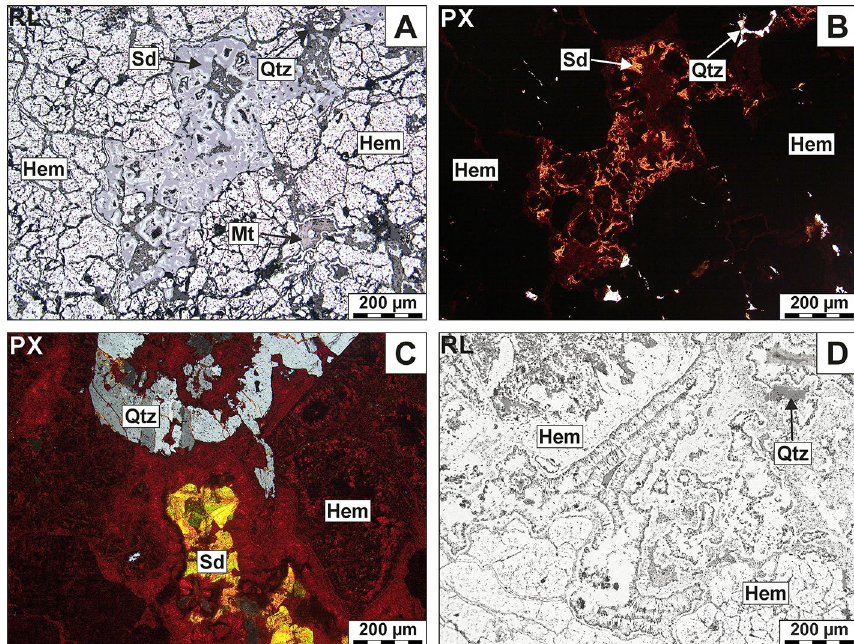
Figure 3. ( A , B ) Intergrowths made of siderite (Sd) and hematite (Hem) (central part of the image), surrounded by replacive isometric crystals of hematite (martite) formed after magnetite (Mt); ( C , D ) Colloform aggregates of hematite accompanied by minor siderite and quartz (Qtz); Note that PX denotes transmitted light mode (with crossed polars) and RL corresponds to the reflected-light mode.